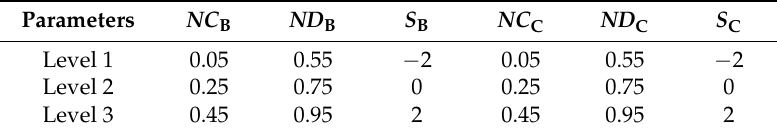
Table 2. Six blade loading parameters with three levels for the orthogonal test.